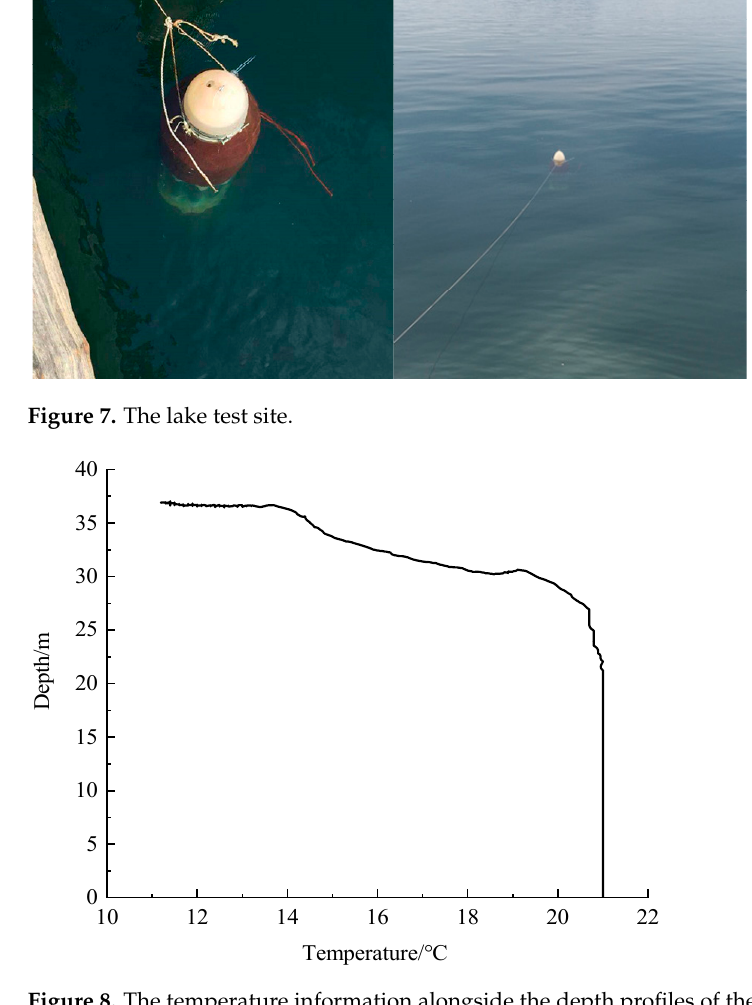
Figure 8. The temperature information alongside the depth profiles of the lake.